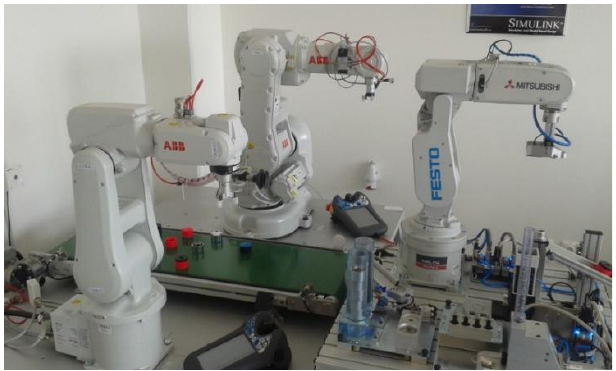
Figure 16. Heterogeneous multi-robotic cell.